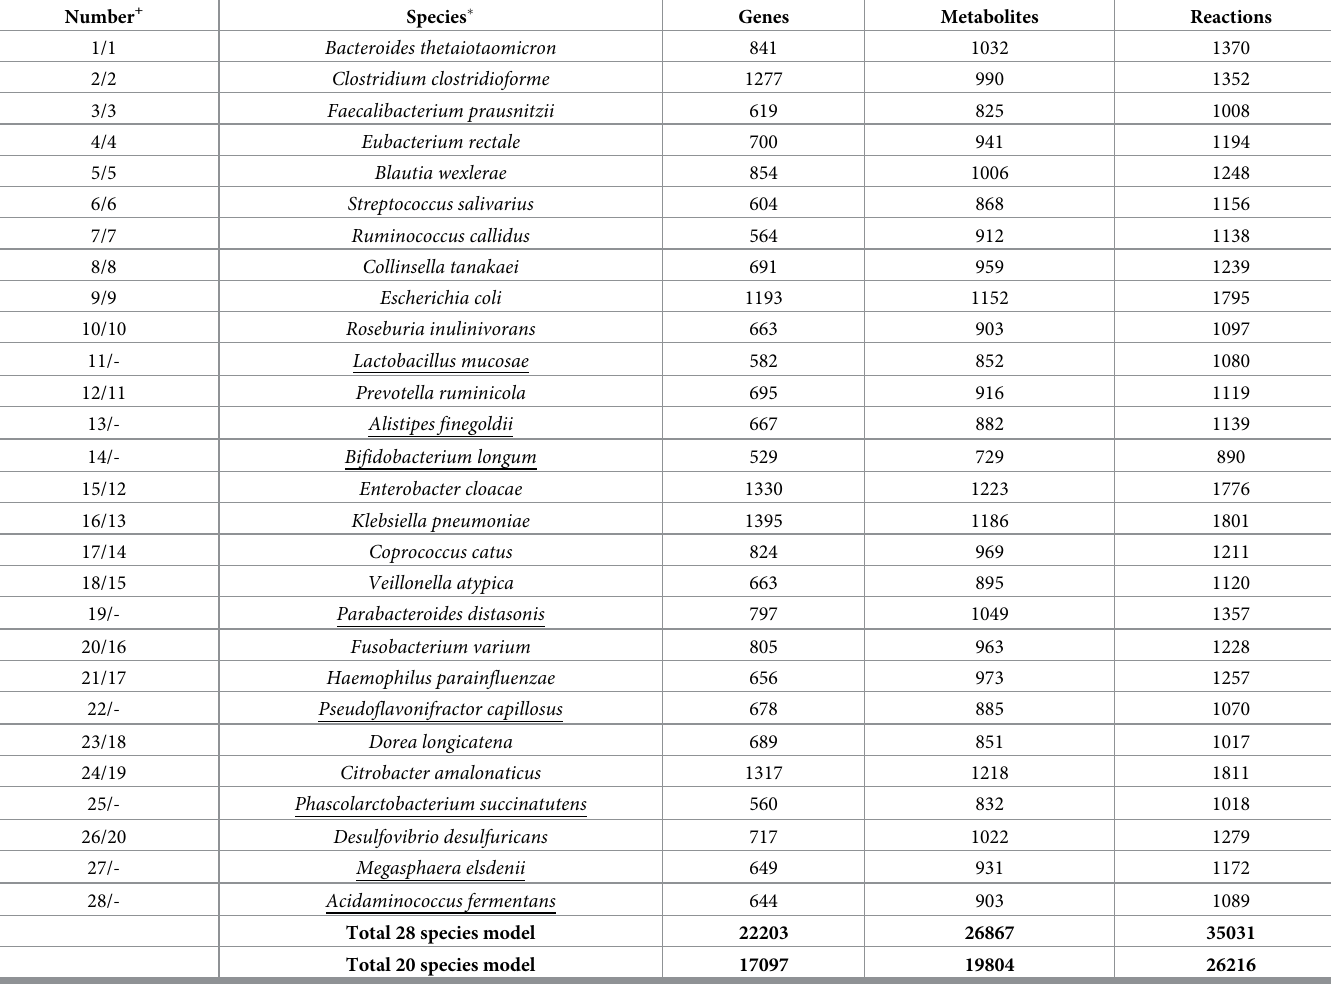
Table 1. Properties of the 28 genome-scale metabolic reconstructions comprising the gut microbiota